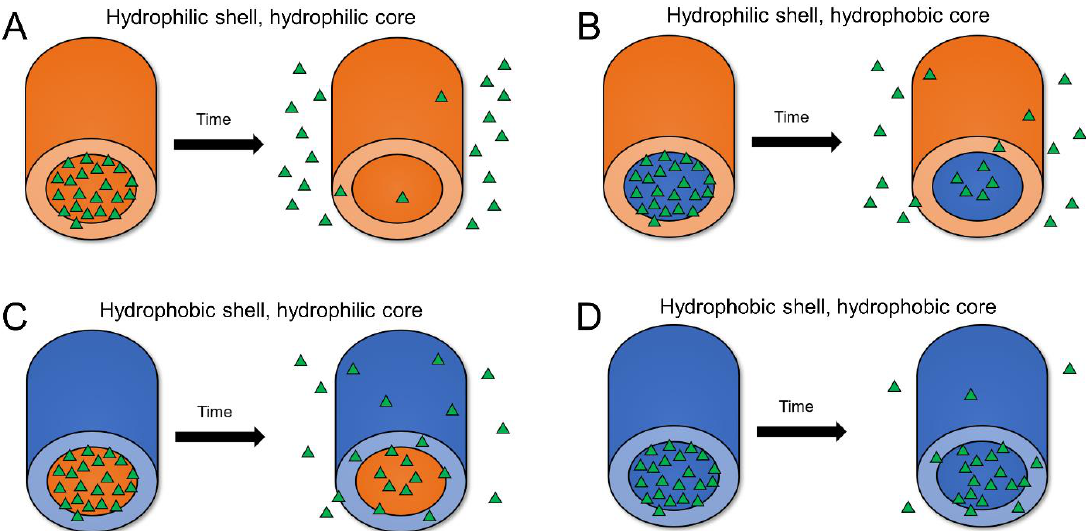
Figure 4. Schematic of anticipated release profiles from different coaxial fiber architectures. Generally, the release of encapsulants from coaxial fibers is dependent on the core and shell hydrophobicity. The release of active agents from coaxial fibers with ( A ) hydrophilic core and shell, ( B ) hydrophobic core and hydrophilic shell, ( C ) hydrophilic core and hydrophobic shell, and ( D ) hydrophobic core and shell are shown. Hydrophilic polymers (shown in orange) typically promote transient release, while more hydrophobic polymers (blue) are typically used to provide short-term or sustained-release.